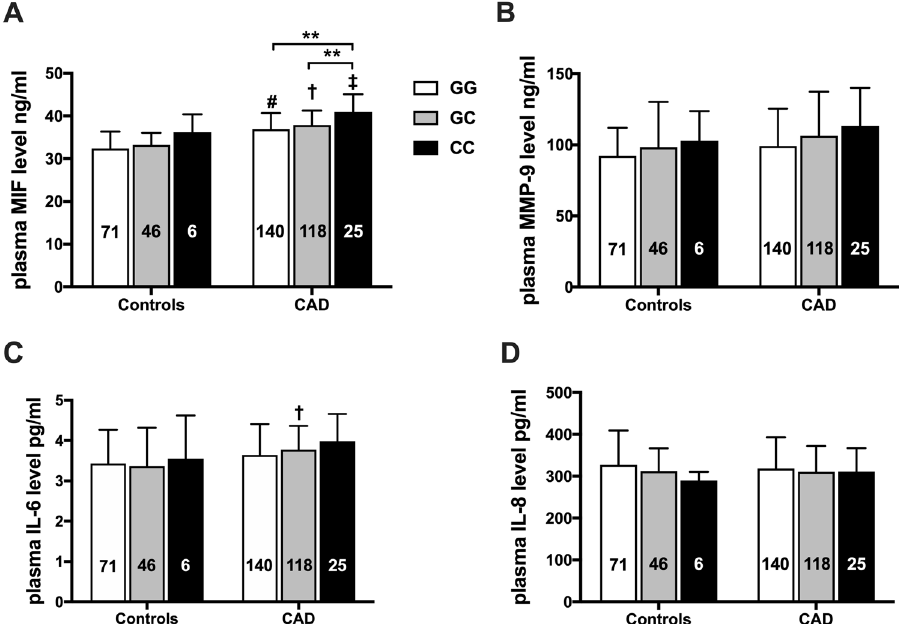
Figure 2. Influence of different genotypes of MIF gene rs755622 variation on plasma levels of MIF (A), MMP-9 (B), IL-6 (C) and IL-8 (D) in controls and patients with coronary artery disease (CAD). The number in each bar indicates the group size. * P < 0.05 , ** P < 0.01 , # P < 0.001 versus control subjects carrying GG genotype, † P < 0.001 versus control subjects carrying GC genotype, ‡ < 0.05 versus control subjects carrying CC genotype. Two-way ANOVA was used for the statistical